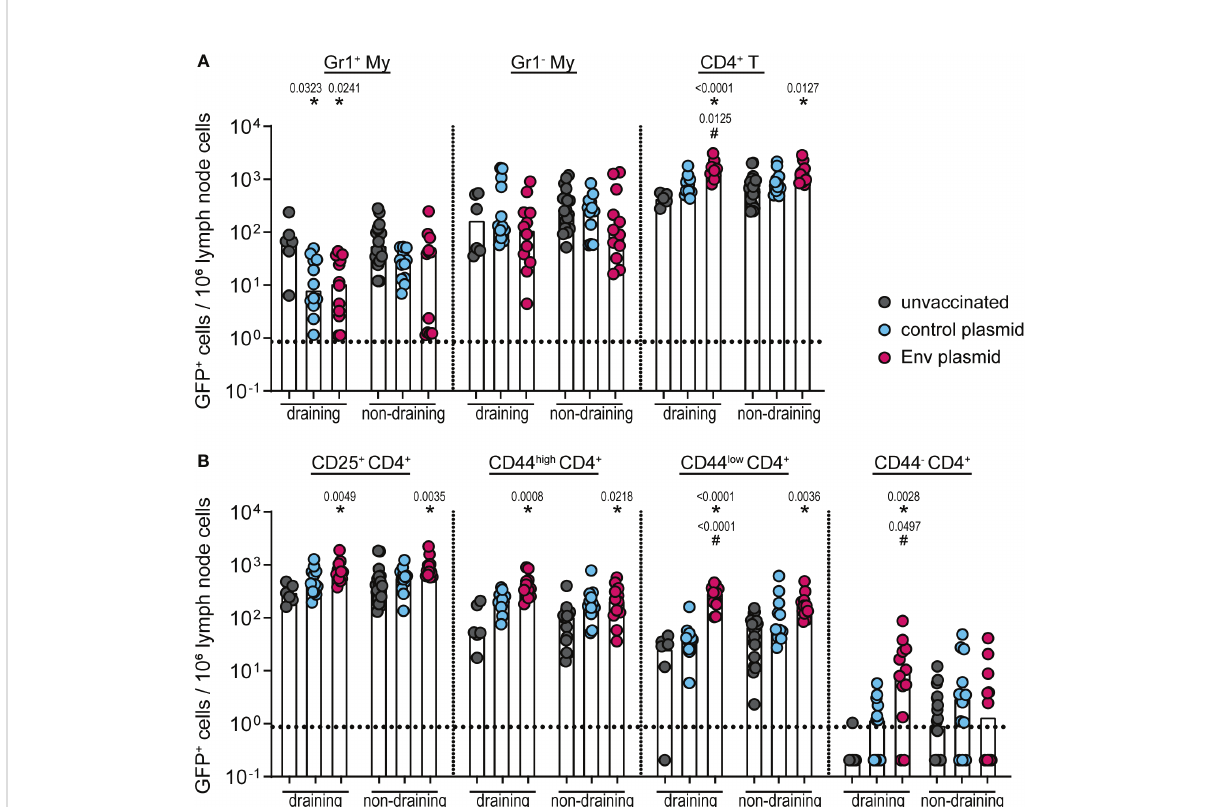
FIGURE 1 IL-10 expression by different cell types after pCG.env immunization of CB6F1-IL-10-eGFP reporter mice. CB6F1-IL-10-eGFP mice were immunized once with 25 µg of F-MuLV Env SU+TM encoding plasmid pCG.env by intramuscular injection followed by in-vivo electroporation. Two weeks after the immunization, mice were sacri fi ced and draining and non-draining lymph nodes were isolated for fl ow cytometric analysis of myeloid cells and CD4 + T cells. The frequency of eGFP + cells of the indicated cell types in 10 6 lymph node cells is shown for Gr1 + and Gr1 − CD11b + myeloid cells and CD4 + T cells (A) and for the indicated CD4 + T-cell subsets (B) . Data from 12 mice per group were acquired in two independent experiments. Each dot indicates an individual mouse, and bars indicate median values. Statistically signi fi cant differences compared with the frequency of the respective cell population in unvaccinated mice are indicated by *, and differences compared with control plasmid- immunized mice are indicated by # ( p < 0.05, Kruskal – Wallis one-way ANOVA on ranks, Dunn ’ s